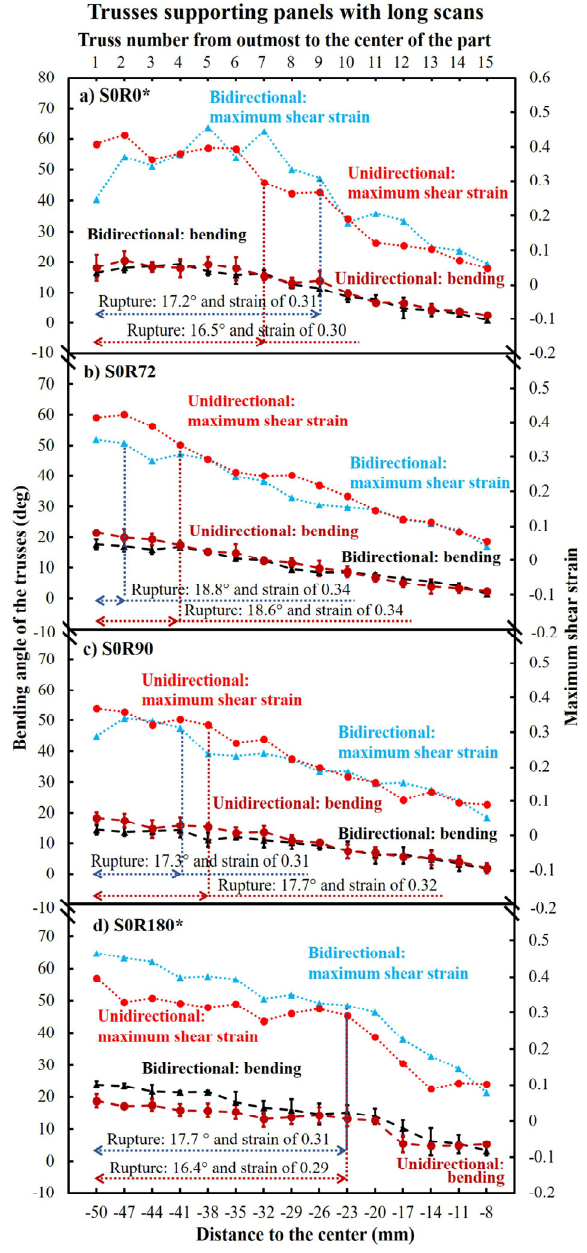
Figure 12. The experimentally measured bending angle and maximum shear strain (derived from maximum bending angle) of trusses supporting panels with long scans. These parts started with a 0° scan angle for their first layer and hence were subjected to a 100 mm long scanning length. * The unidirectional S0R0 and S0R180 panels were only 1.15 mm (instead of 2 mm) thick due to the process failure after excessive bending.